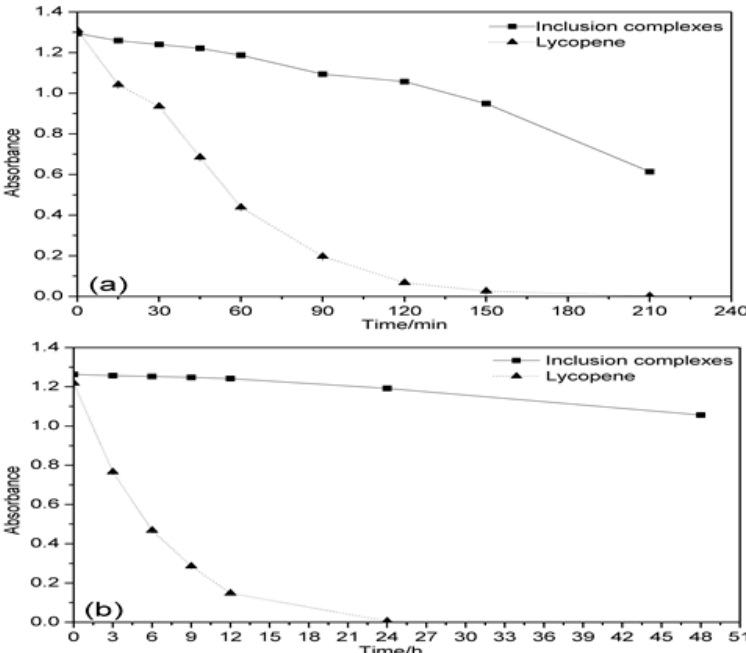
Figure 5. The effect of thermal ( a ) and illumination ( b ) on the stability of the lycopene and inclusion complexes.